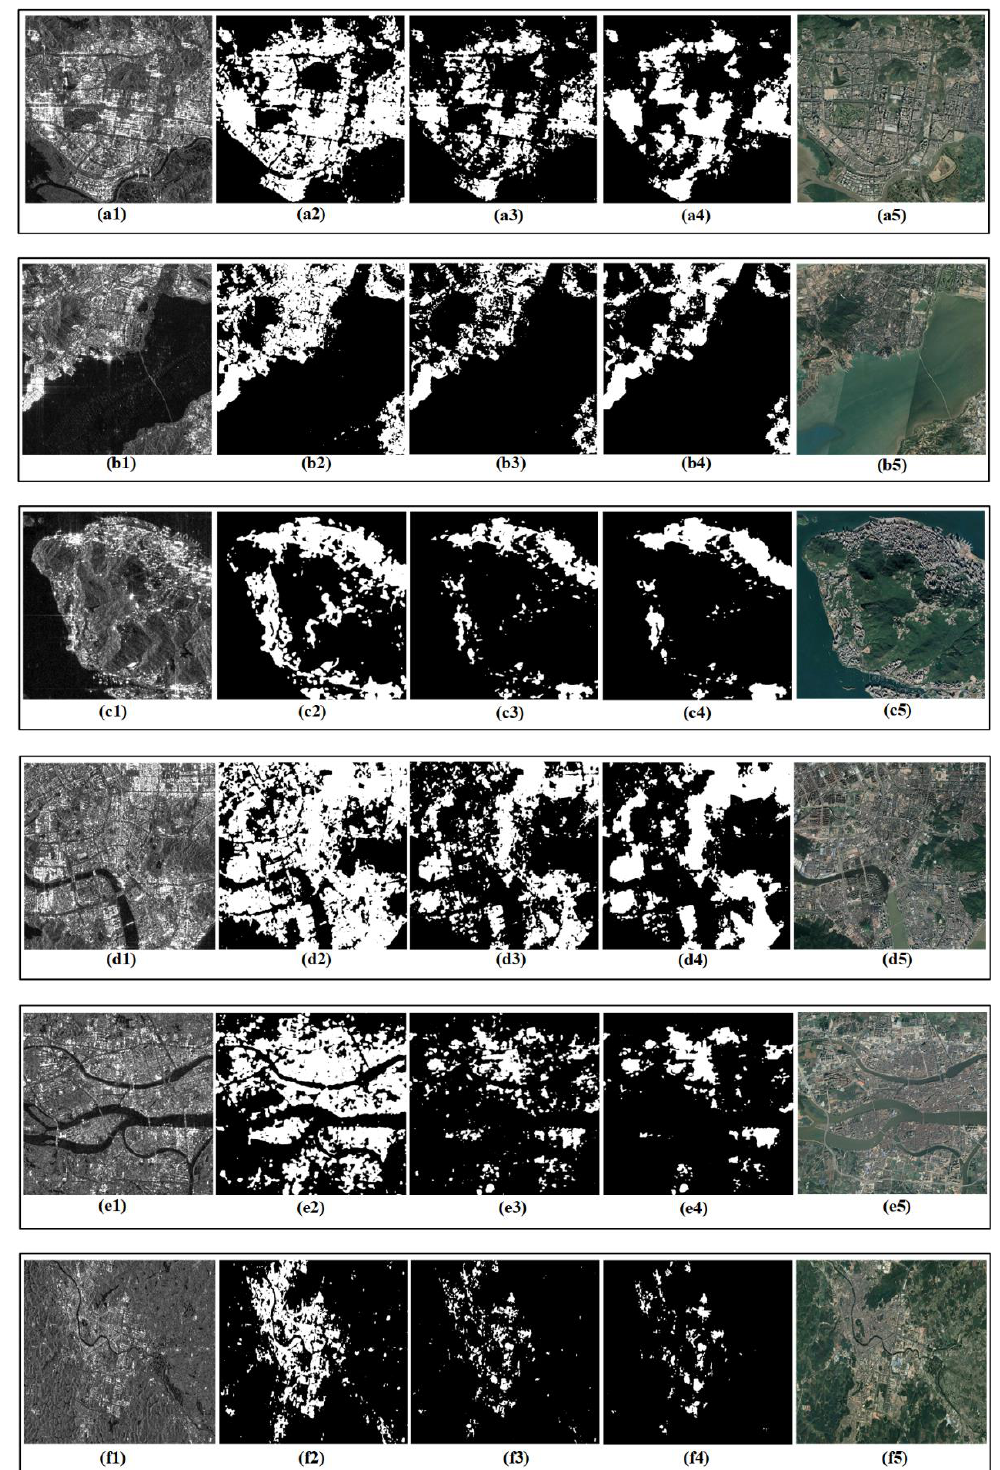
Figure 12. BAs extraction results using different deep learning methods. ( a1 – f1 ) SAR images of the six regions. ( a2 – f2 ), ( a3 – f3 ), ( a4 – f4 ) Results of our proposed method, BA-UNet and PSPNet, respectively. ( a5 – f5 ) The corresponding optical image from Google Earth.